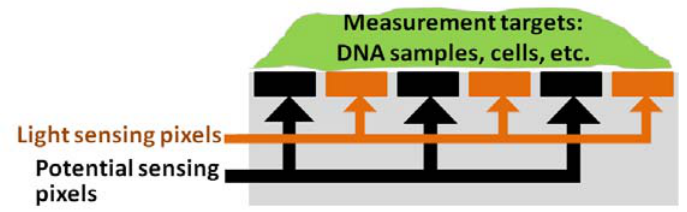
Figure 5. Concept of the optical and potential dual image CMOS sensor [78]. The actual sensor consisted of a 176 × 144 pixel array with 7.5 × 7.5 µm pixel sizes, and 88 columns were spared for optical-sensing and the rest 88 for potential-sensing [78]. Adapted with the permission of Elsevier.